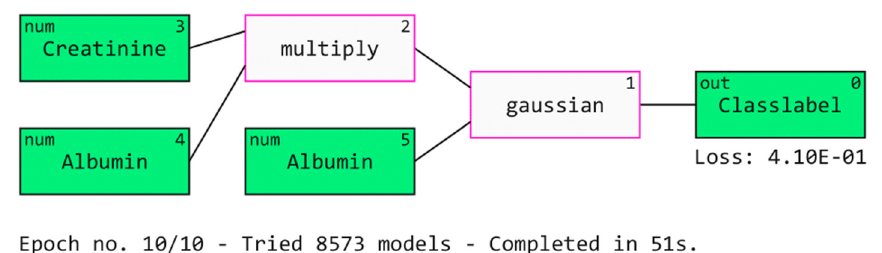
Figure 13. The use of QGraph to explain model predictions.